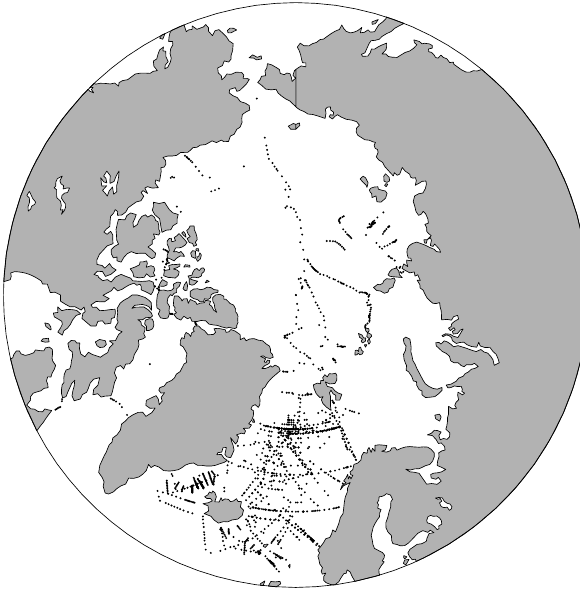
Figure 1. Map of the Arctic Mediterranean Seas showing all sta- tions with CFC data in the CARINA data